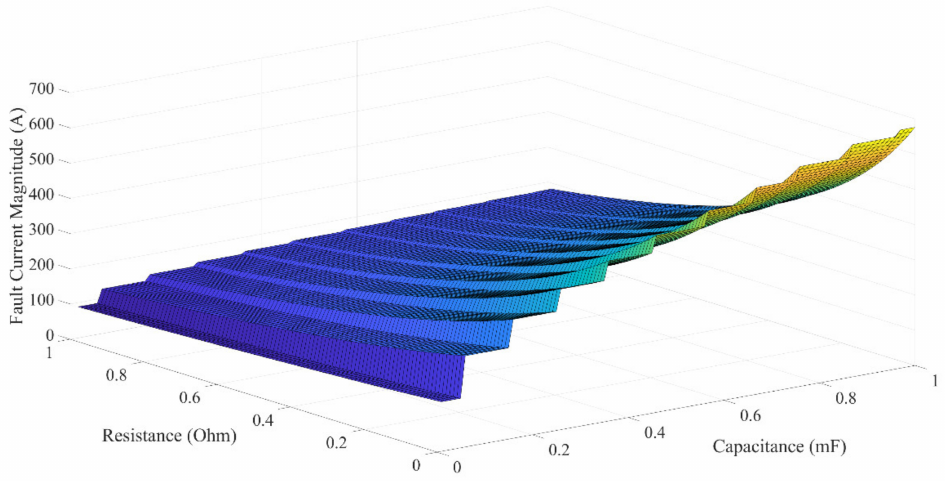
Figure 5. Fault current magnitude for different resistances ( R ) and VSC capacitances ( C ).